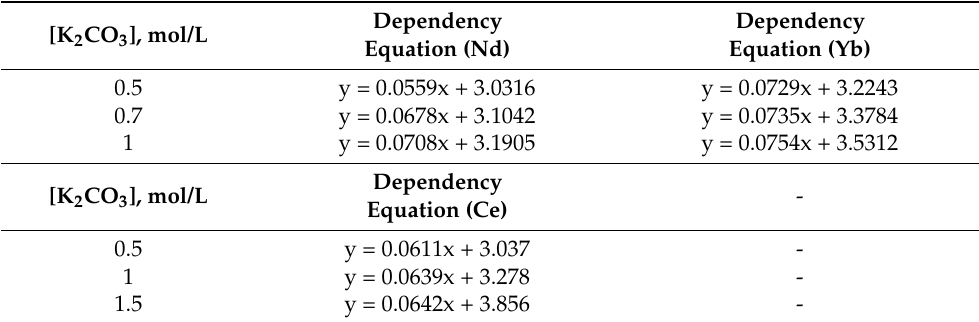
Table 7. Empirical dependence of the degree of recovery into the solution on the concentration of potassium carbonate.